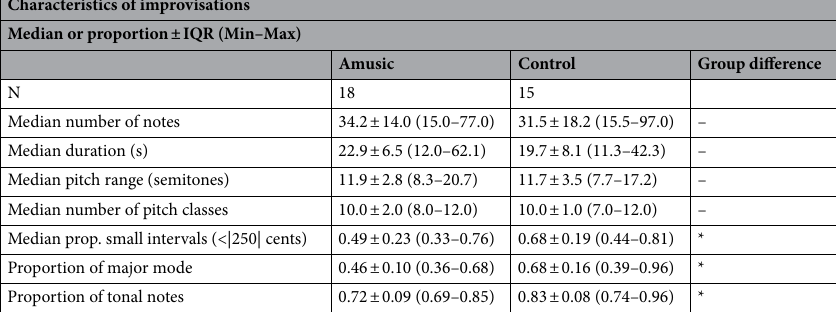
Table 1. Improvisation characteristics by group. Scores were summarized by individual (28 trials) prior to group-level summary statistics displayed here. Dash indicates not significant, asterisk indicates p <